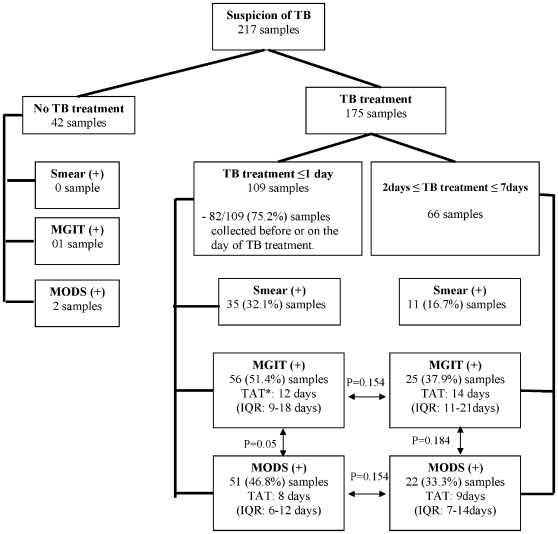
Detection rates of Smear, MGIT and MODS in relation to TB treatment.P values for comparison of detection rates between MODS and MGIT. * TAT: Turn around time.